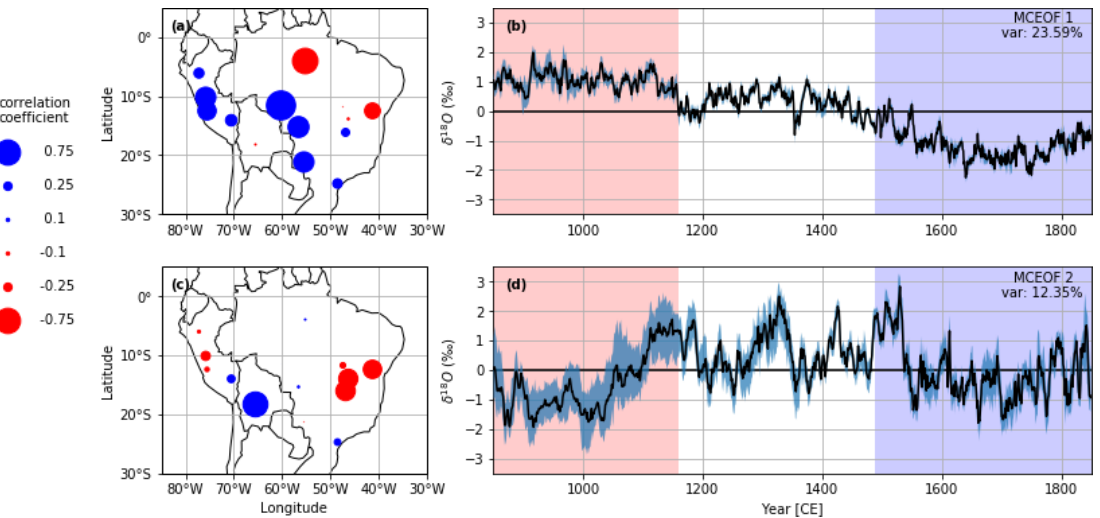
Figure 2. MCEOF decomposition of the oxygen isotope proxy network. (a) MCEOF1. The magnitude of the loadings in the spatial patterns represent the correlation coefficient between the median of the Monte Carlo ensemble of proxy records at those locations and the corre- sponding principal component (PC) time series for that mode, (b) PC1. Blue shading indicates the total envelope of ensemble variability. (c) Same as in (a) but for MCEOF2. (d) Same as in (b) but for PC2. Pink and blue shading in (b) and (d) highlight the MCA and LIA periods,